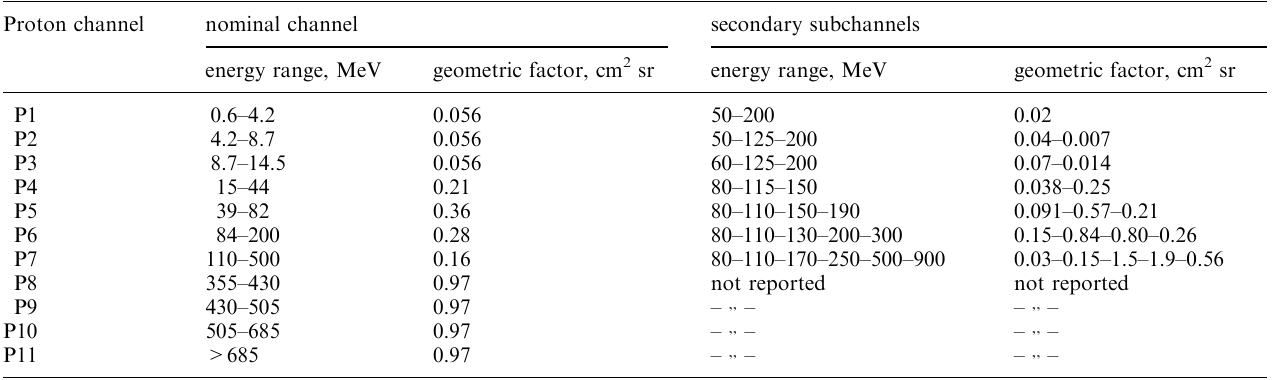
Table 3. The energetic proton channels of GOES Proton